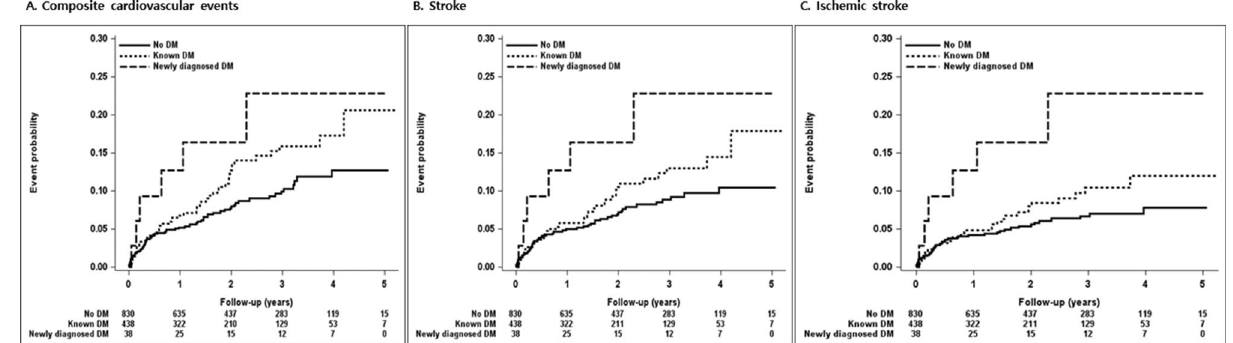
Figure 1. Kaplan–Meier estimates of event probability expressed as diabetes